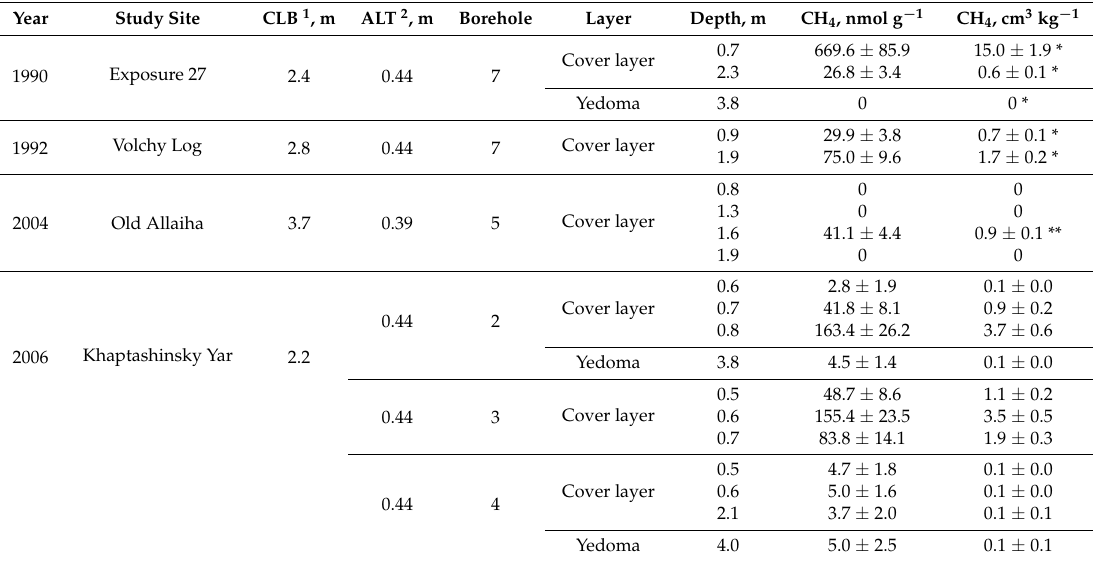
Table A3. Methane concentration in Yedoma and the Holocene Cover